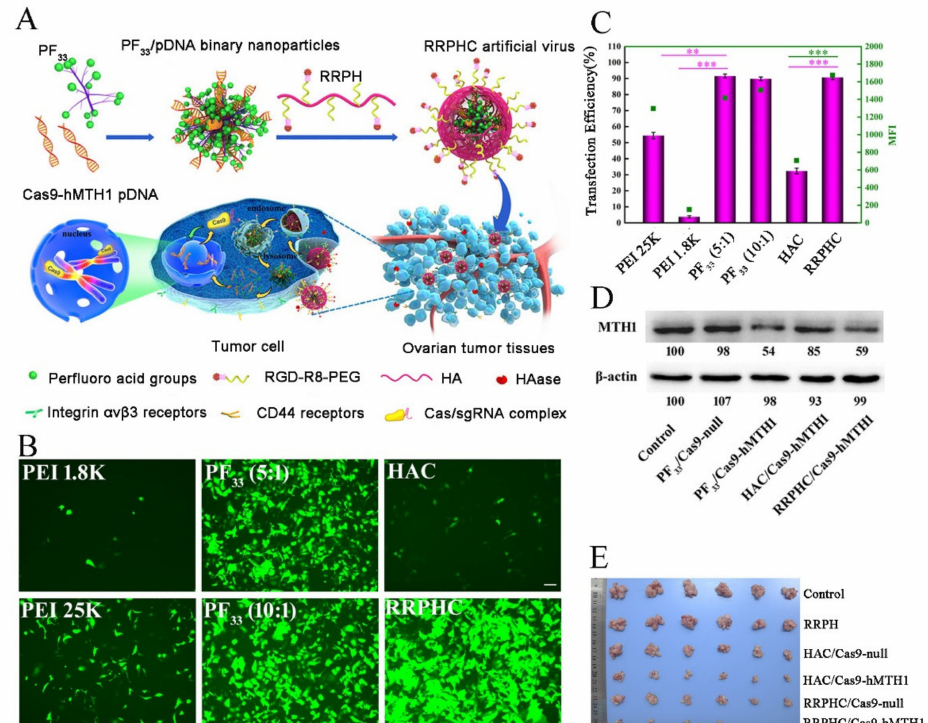
Figure 4. Fluorinated PEI-based artificial virus for Cas9 plasmids delivery. ( A ) Schematic illustration of the multifunctional artificial virus. ( B ) Transfection efficiency of different nanoparticles loading EGFP plasmids at 24 h. The images were taken by fluorescence microscopy in SKOV3 cancer cells. ( C ) Quantitative analysis of transfection efficiency in SKOV3 cells. ( D ) Western-blotting assays reflecting the expression level of MTH1 protein. ( E ) Representative photos of ovarian cancer cells after the in vivo treatment. Significant differences between groups were indicated as ** p < 0.01, and *** p < 0.001. Reproduced with permission from [40]. Copyright ACS Publications,